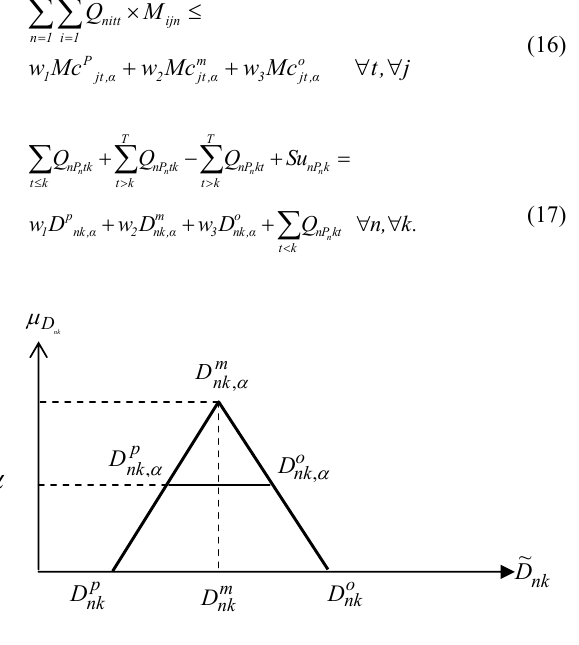
Fig. 3. The distribution of triangular fuzzy